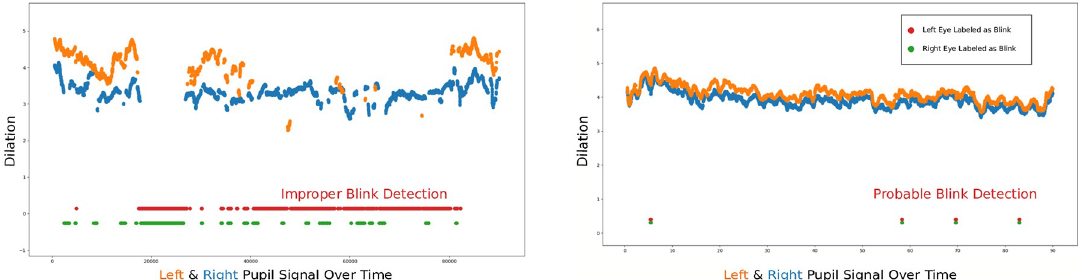
Fig 3. Blink detection in the raw gaze data. ( a ) Low Data Quality Example ( b ) High Data Quality Example. The raw pupil signal of the left and right eye (orange and blue dots) over the course of image presentation. Red and green dots in the lower part show when the eye tracker labels the data point as a blink for the left and right eye, respectively. The particular subject in 3a had a high tracking ratio, though many data samples could be incorrectly labeled as blinks. The participant in 3b also has a high tracking ratio and his or her data appears to be acceptable